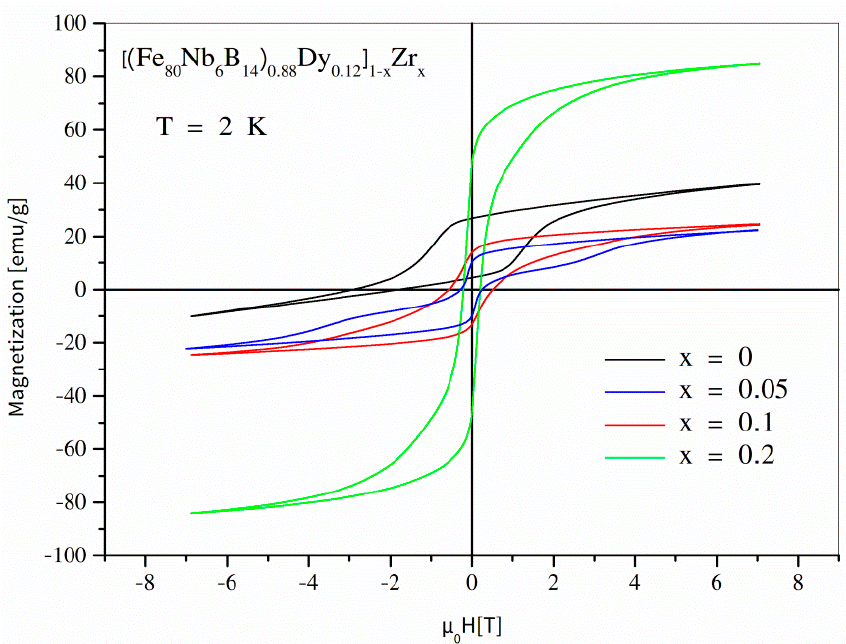
Figure 6. Hysteresis loops for selected [(Fe 80 Nb 6 B 14 ) 0.88 Dy 0.12 ] 1 − x Zr x alloys measured at a low temperature of 2 K.